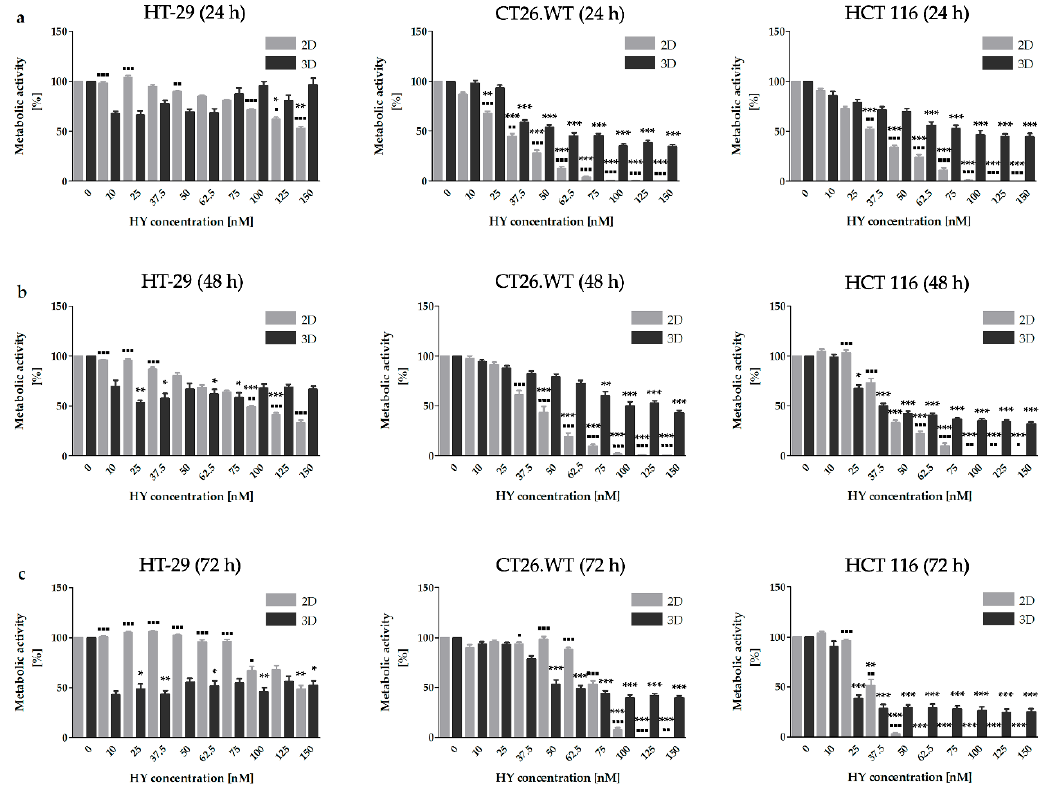
Figure 1. Metabolic activity in cell lines after treatment with HY-PDT. The 3D cell model is more resistant to HY-PDT in comparison to a 2D cell model. Metabolic activity was assessed in all experimental cell lines 24 h ( a ), 48 h ( b ), and 72 h ( c ) after irradiation by MTT assay. The results are expressed as the mean value ± SD of three independent experiments. The experimental groups cultivated in 2D and 3D cell models were compared with the control group (* p < 0.05, ** p < 0.01, *** p < 0.001). The experimental groups cultivated using 2D cell models were compared with experimental groups cultivated in 3D cell models ( ▪ p < 0.05, ▪▪ p < 0.01, ▪▪▪ p < 0.001).